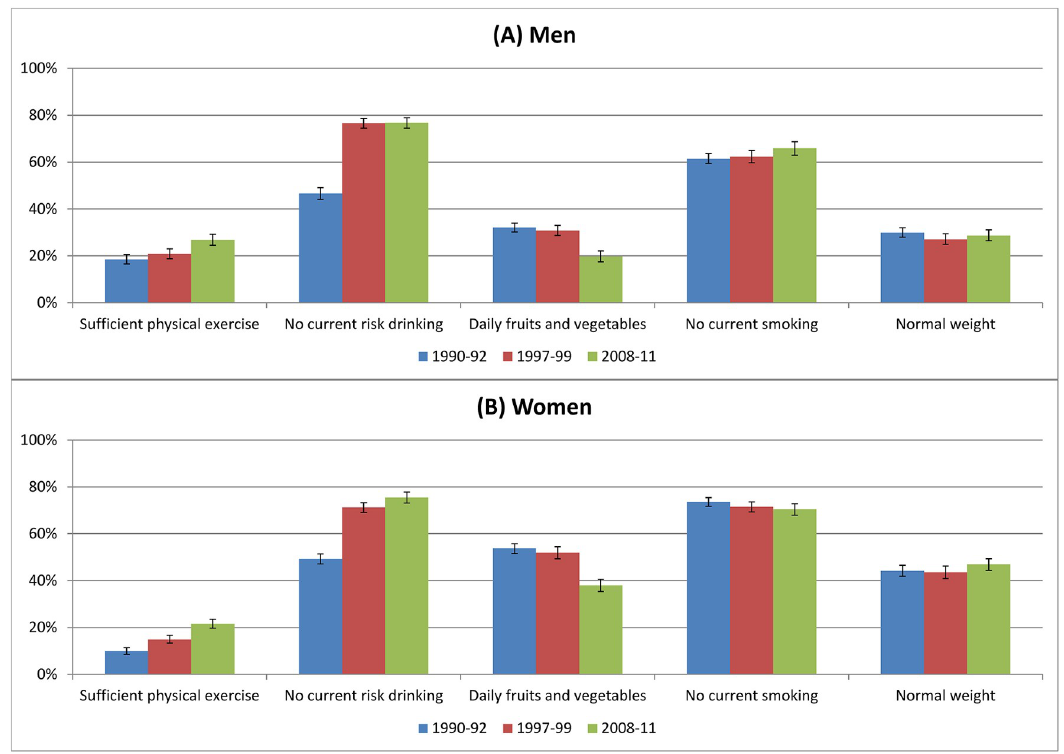
Fig 1. Prevalence (%, 95%-CI) of individual healthy behavior factors among men (A) and women (B) aged 25–69 years.